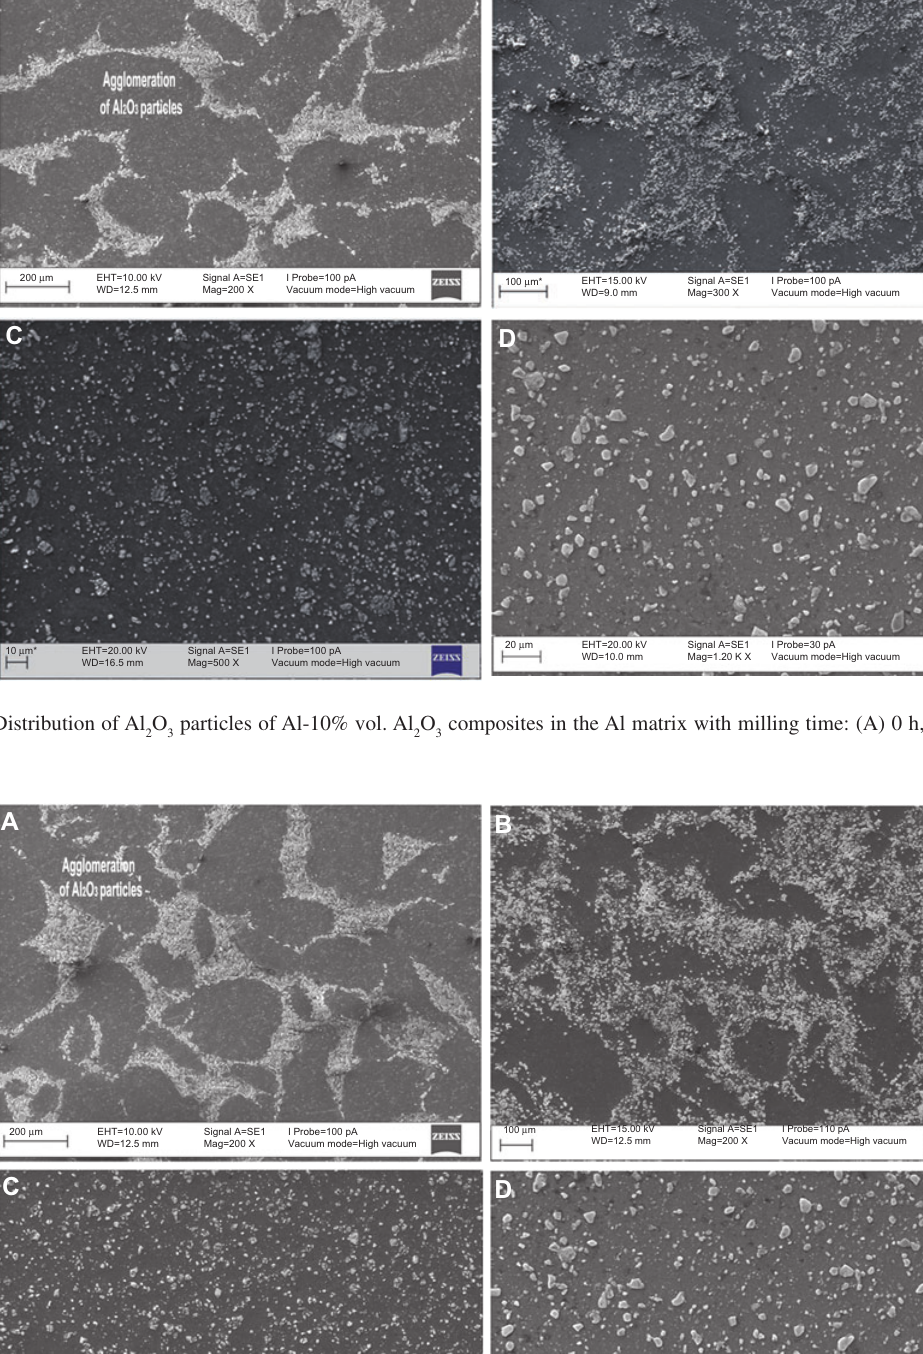
O particles of Al-15 % vol. Al 2 3